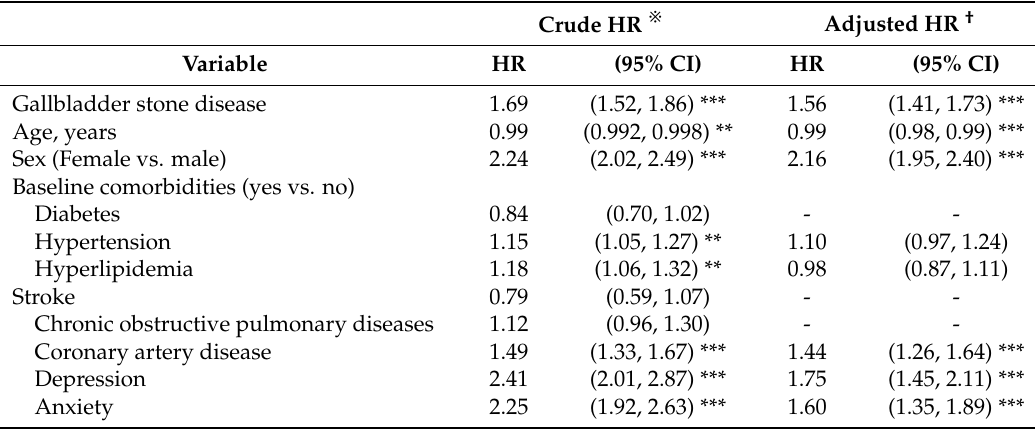
Table 3. Hazard ratios of migraine in association with sex, age, and comorbidities in univariable and multivariable Cox regression models.